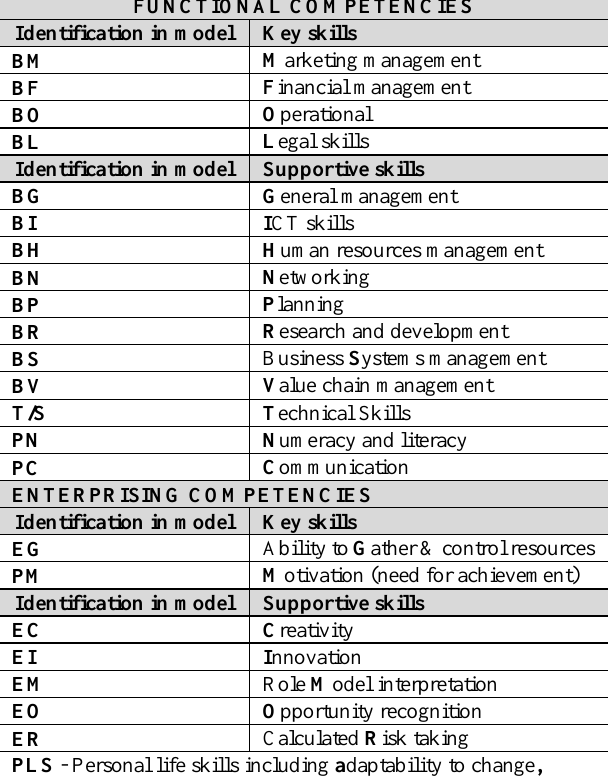
Figure 1: The link between competencies and skills The integrated model for increasing entrepreneurial